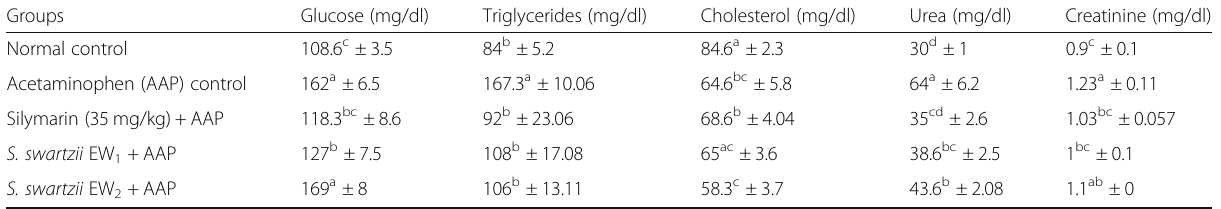
Table 2 Effect of Crude Sulphated Polysaccharides of Sargassum swartzii on Glucose, Urea, Creatinine, Triglycerides and Cholesterol in Acetaminophen-Intoxicated Rats